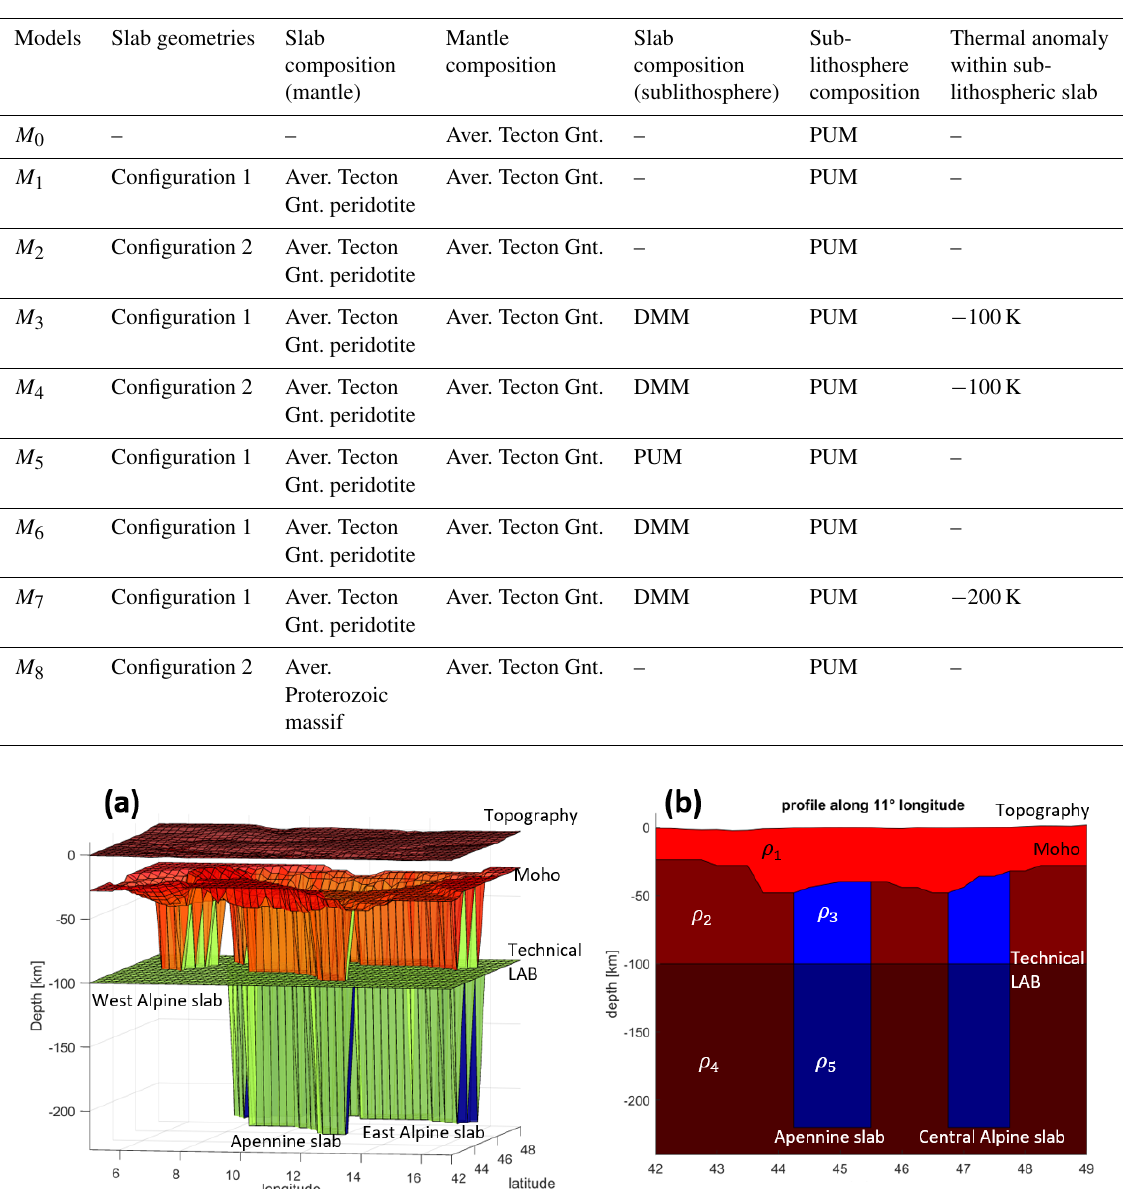
Table 2. Different LitMod models and their incorporated lithospheric and sublithospheric structures and compositions. Models Slab geometries Slab Mantle Sub-